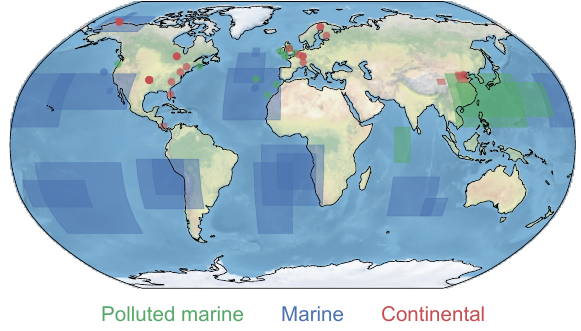
Figure 1. Locations of in situ observational data reported by Kary- dis et al. (2011). Different colors correspond to classifications of different aerosol